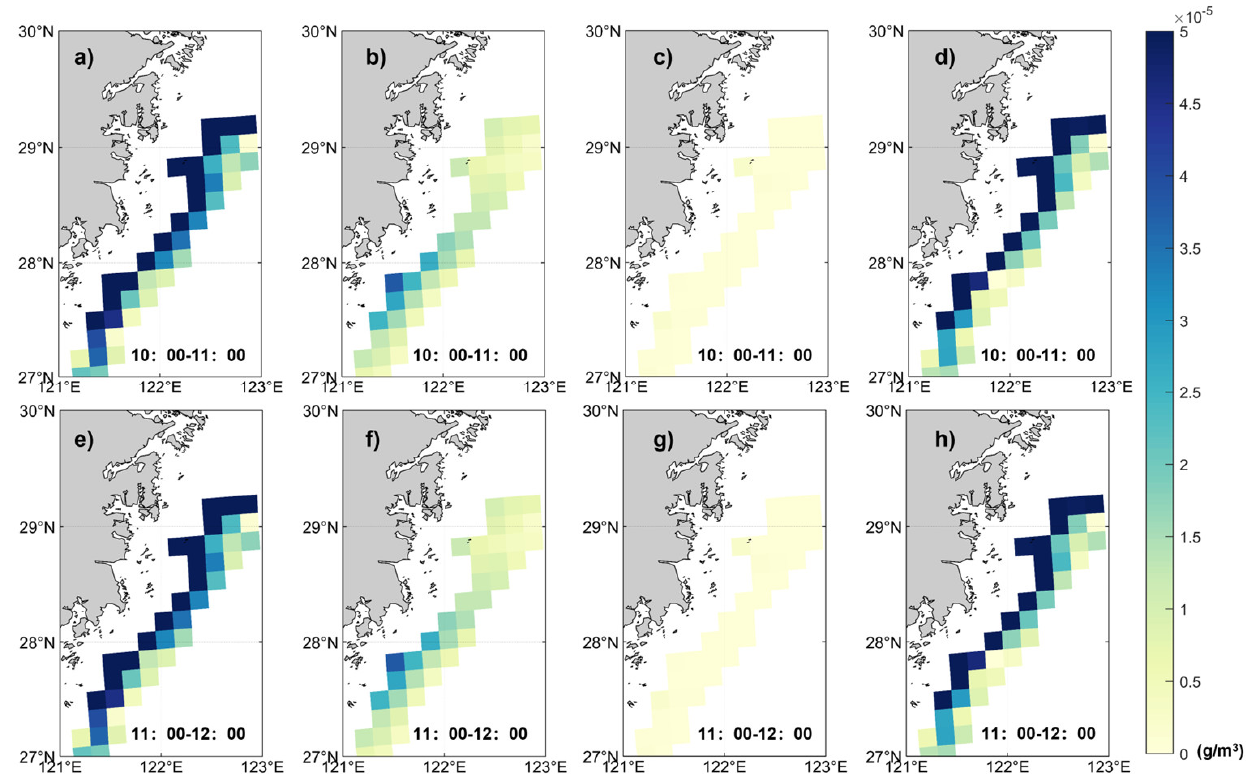
Figure 10. Spatial distribution of hourly variation in TSS, advection term, horizontal diffusion term, and vertical term at 10:00−11:00 ( a − d ) and 11:00−12:00 ( e − h ) on 3 August 2013.